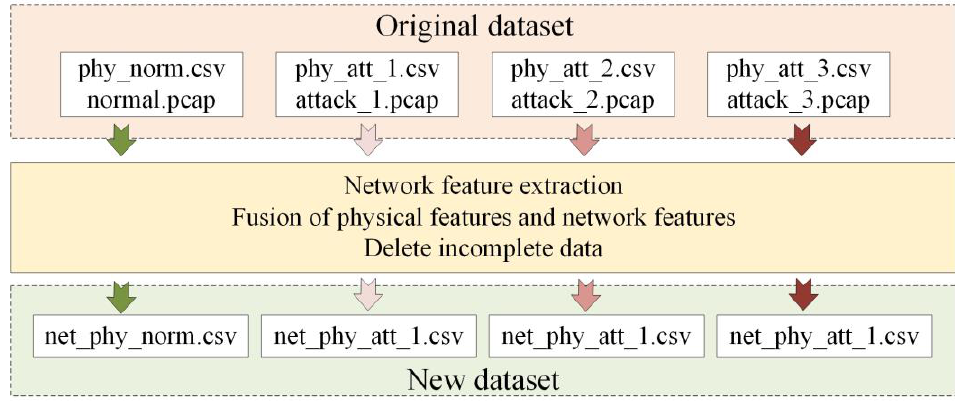
Figure 3. Additional network feature extraction and fusion architecture. Table 3. Cyber – physical dataset after feature fusion.